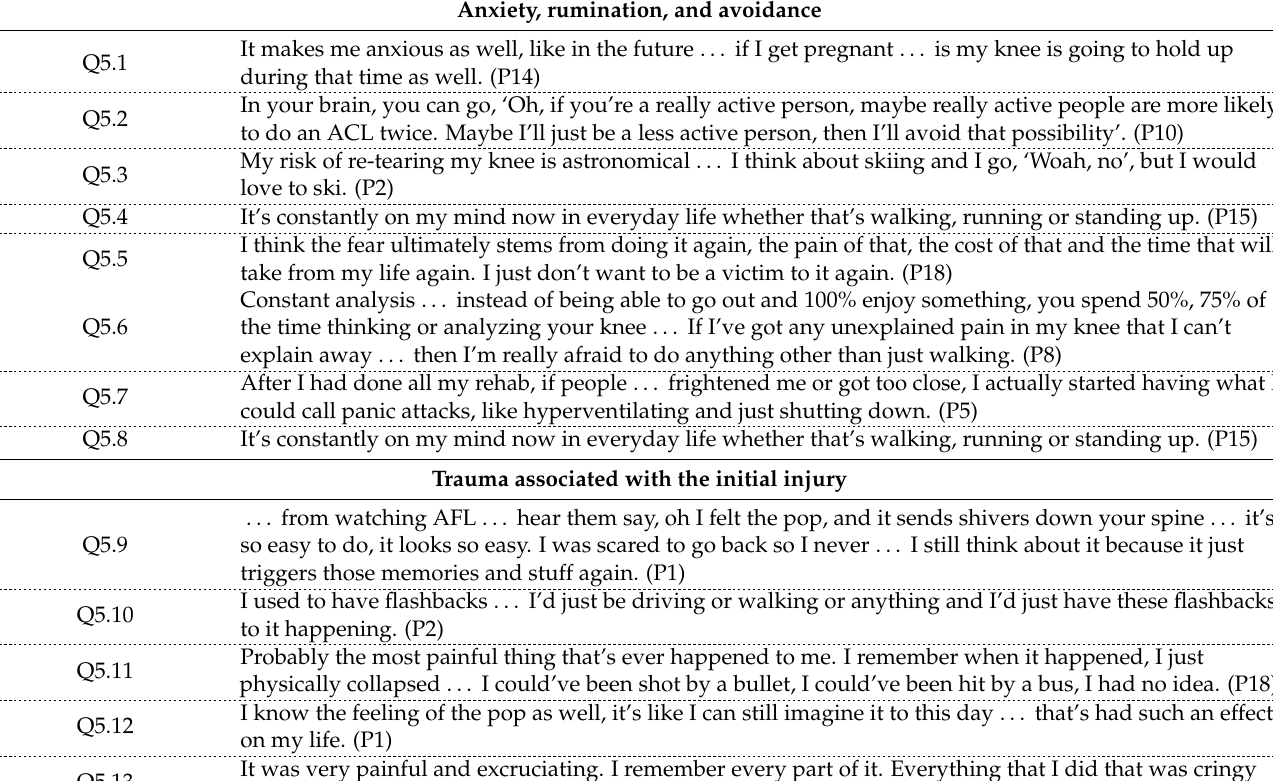
Table 6. Supporting Quotes to theme 5—ongoing psychological barriers driving fear. Anxiety, rumination, and avoidance